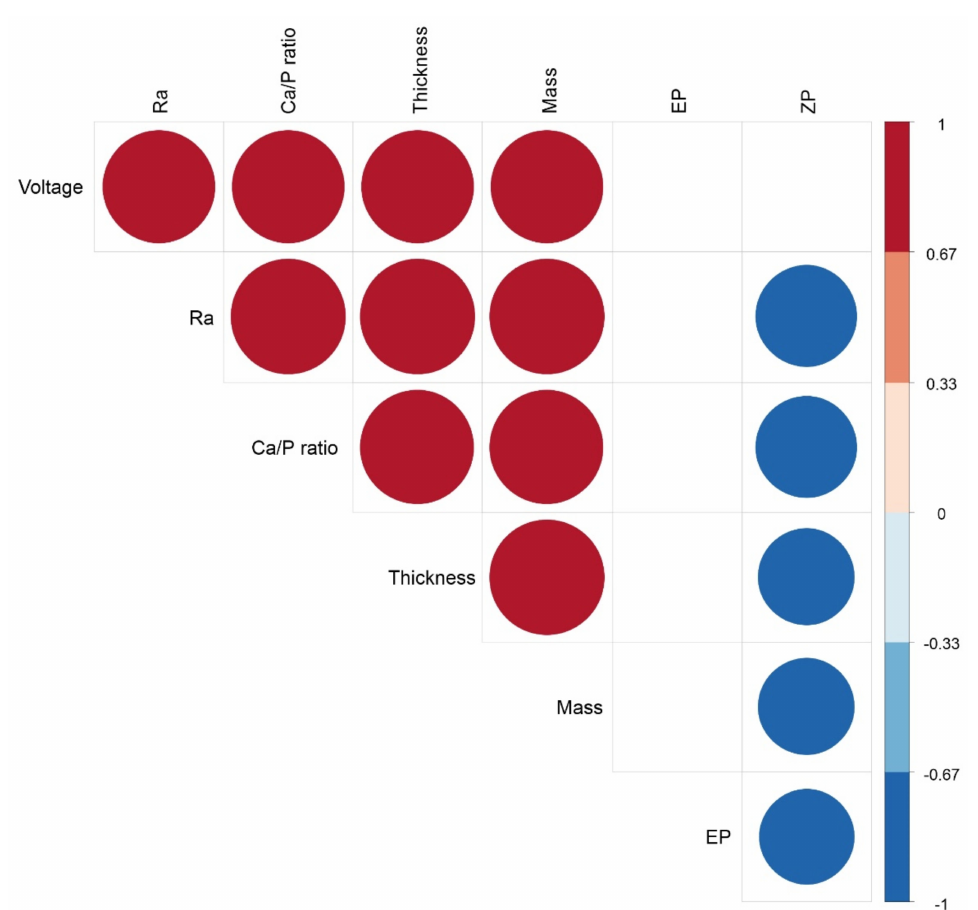
Figure 5. Strong relationships ( r S > 0.75; n = 12–30) between the technological and physicochemical properties of micro-arc CaP-coated Ti substrates. Positive and negative Spearman’s rank correlations are shown by red and blue circles,